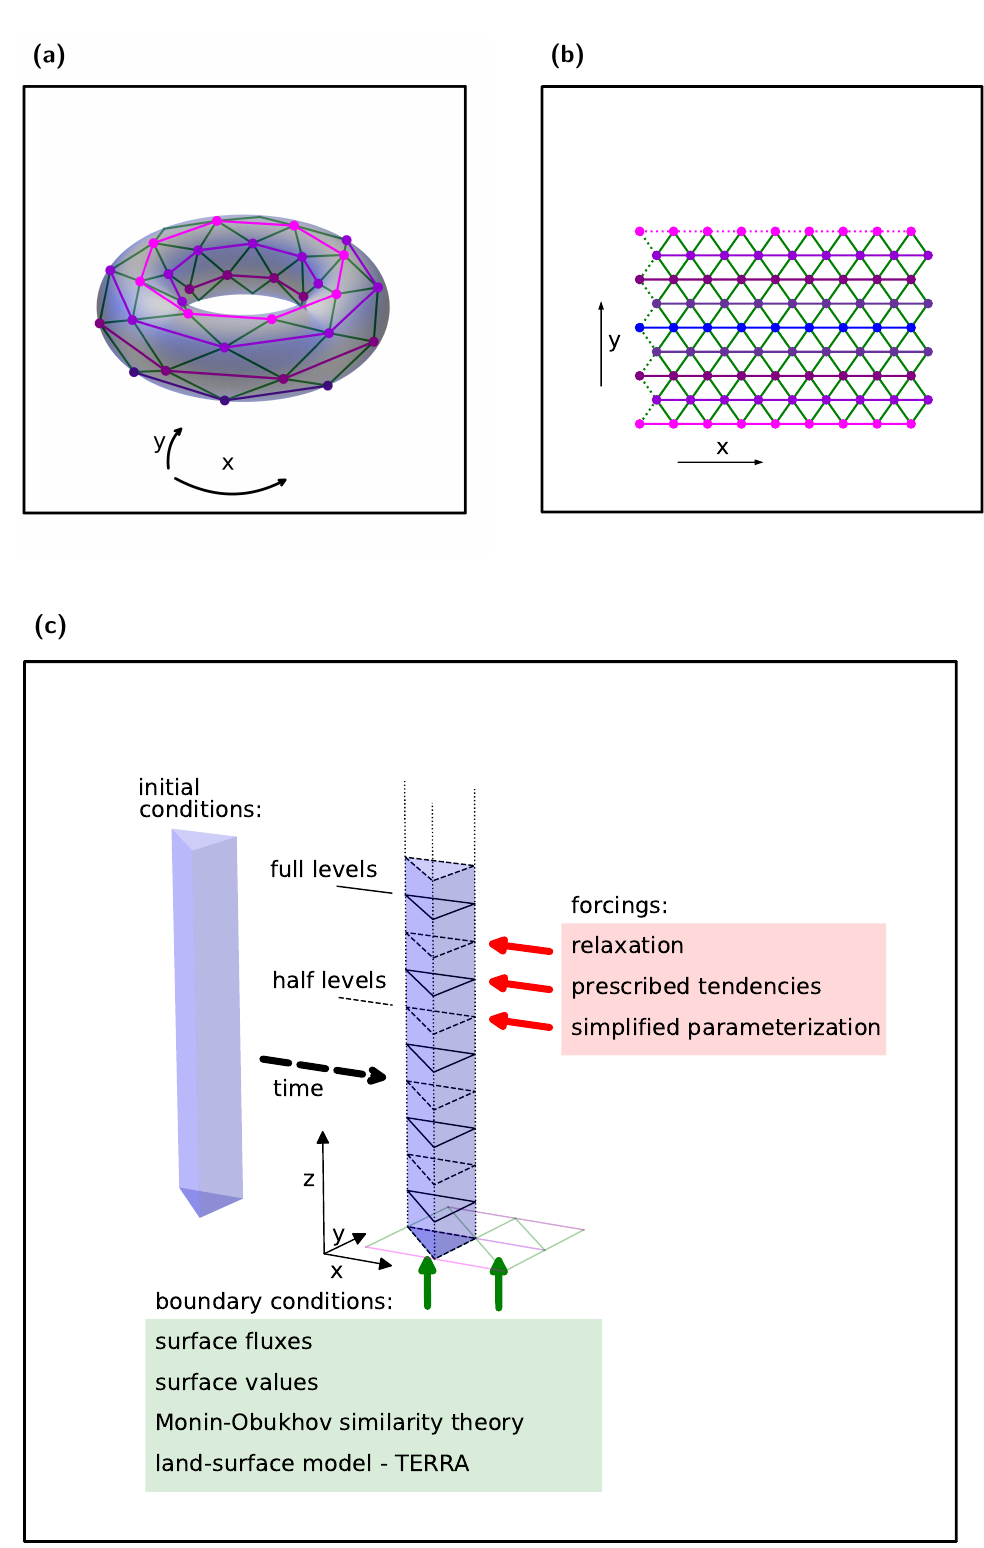
Figure 1. Visualization of the horizontal (8 × 8) and the vertical grid used in the ICON SCM. The horizontal grid is displayed as a pseudo 2D torus grid, which is periodic in the x and y direction ( a ), and as an unrolled grid in a plane ( b ). The vertical grid ( c ) is displayed together with inputs that are required for the ICON SCM setup. Options for forcing and boundary conditions are listed in the corresponding